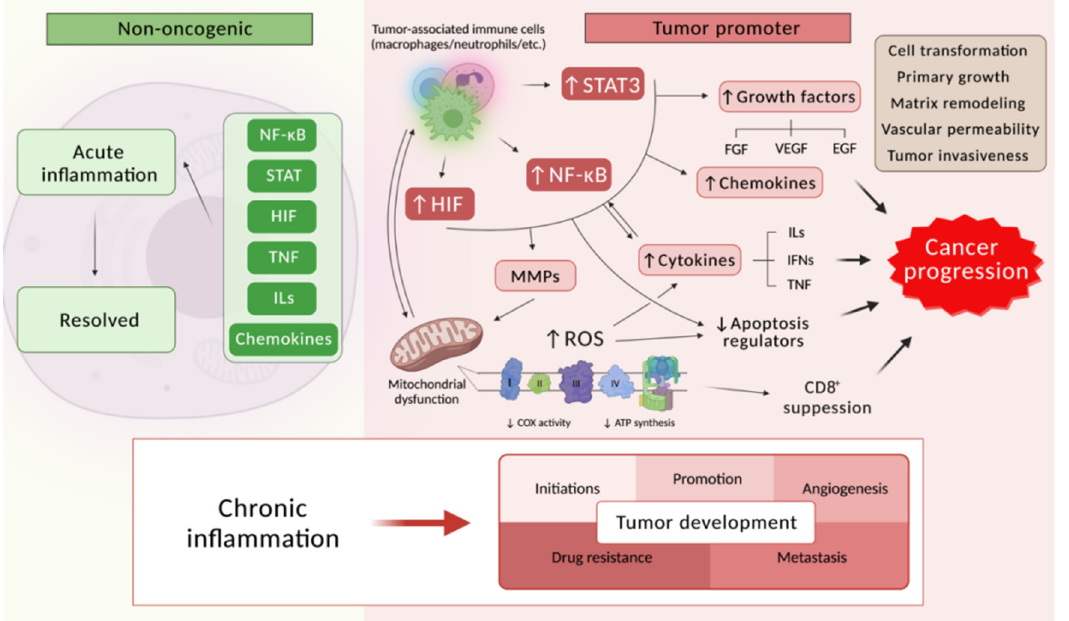
Figure 8. Non-oncogenic inflammation pathway and tumor-promoting inflammation. In the case of the acute phase of inflammation, inflammation is activated which occurs due to pro- and then anti-inflammatory modulators. If acute inflammation is not eliminated, pathologies with chronic inflammation develop. Chronic inflammatory or infectious conditions mediate the risk of cancer development and progression due to the activation by tumor-associated immune cells of transcription factors, mainly nuclear factor NF- κ B, signal transducer and activator of transcription 3 (STAT3), and hypoxia-inducible factor (HIF1) in cells. At the same time, transcription factors coordinate the production of growth factors and various enzymes, as well as inflammatory mediators, including chemokines and cytokines, which can in turn activate the same transcription factors in inflammatory, stromal, and tumor cells, contributing to the formation of cancer-related inflammatory microenvironment. Chronic inflammation leads to mitochondrial dysfunction and a decrease in ATP synthesis, causing hyperproduction of reactive oxygen species that inhibit the activity of apoptosis regulators and CD 8+ cytotoxic lymphocytes. All of these events that occur in chronic inflammation contribute to cancer progression and participate in all of the major stages of tumor development, from nucleation to metastasis and the formation of drug resistance.